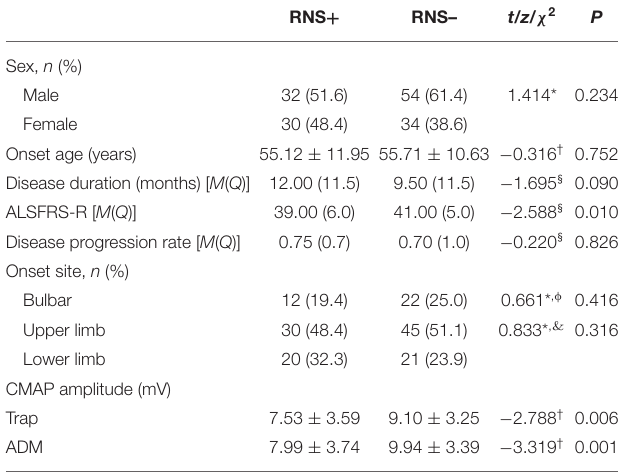
TABLE 2 | Comparison of positive and negative decrements in ALS patients.